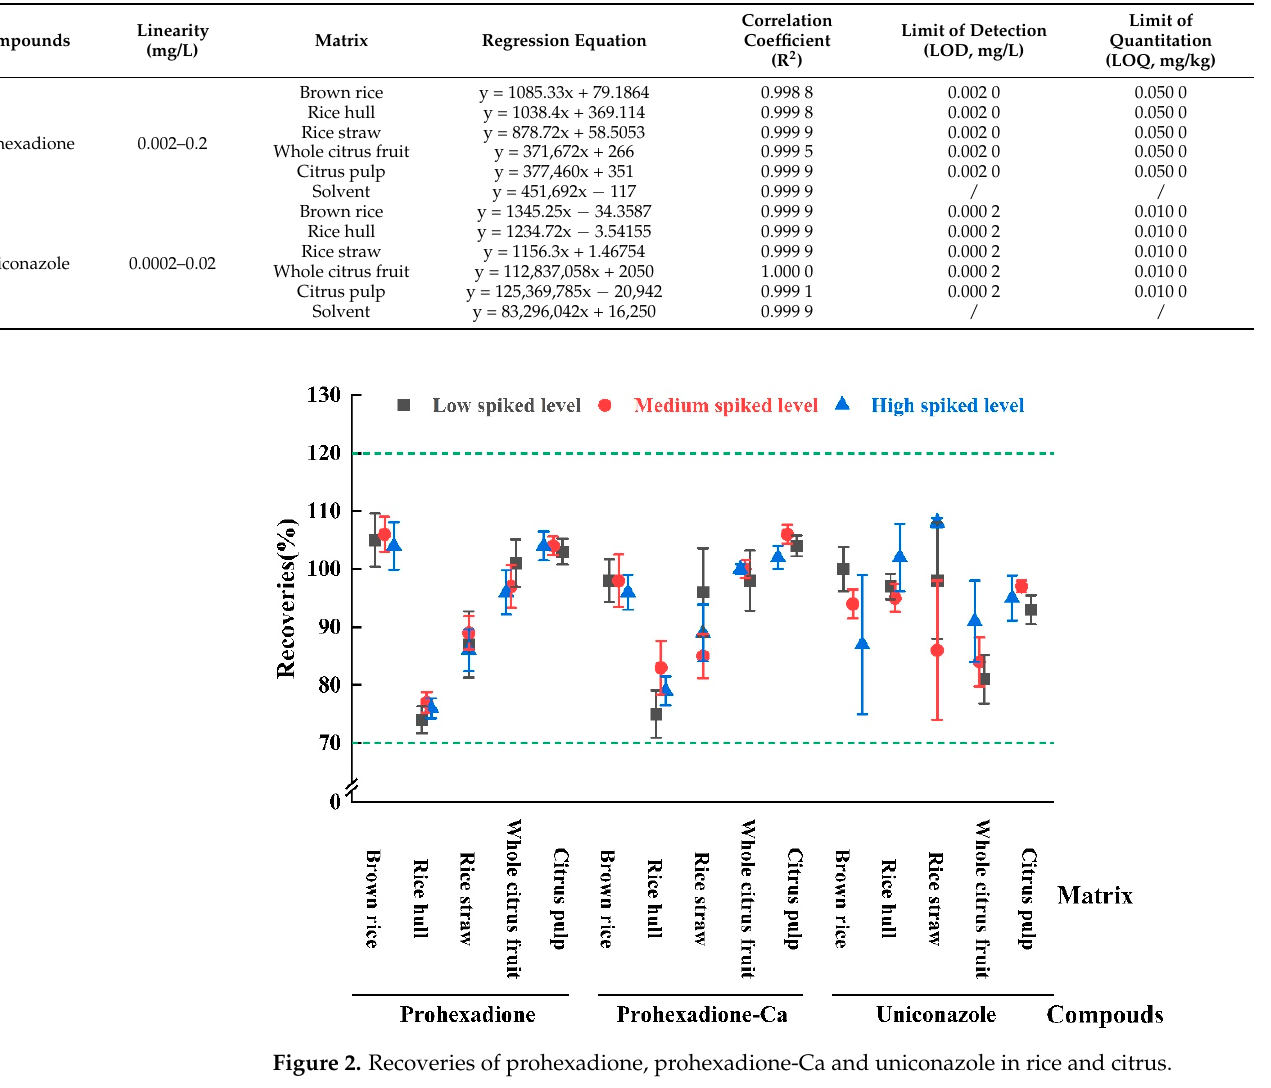
Table 1. Relevant parameters of the matrix-based standard curves.